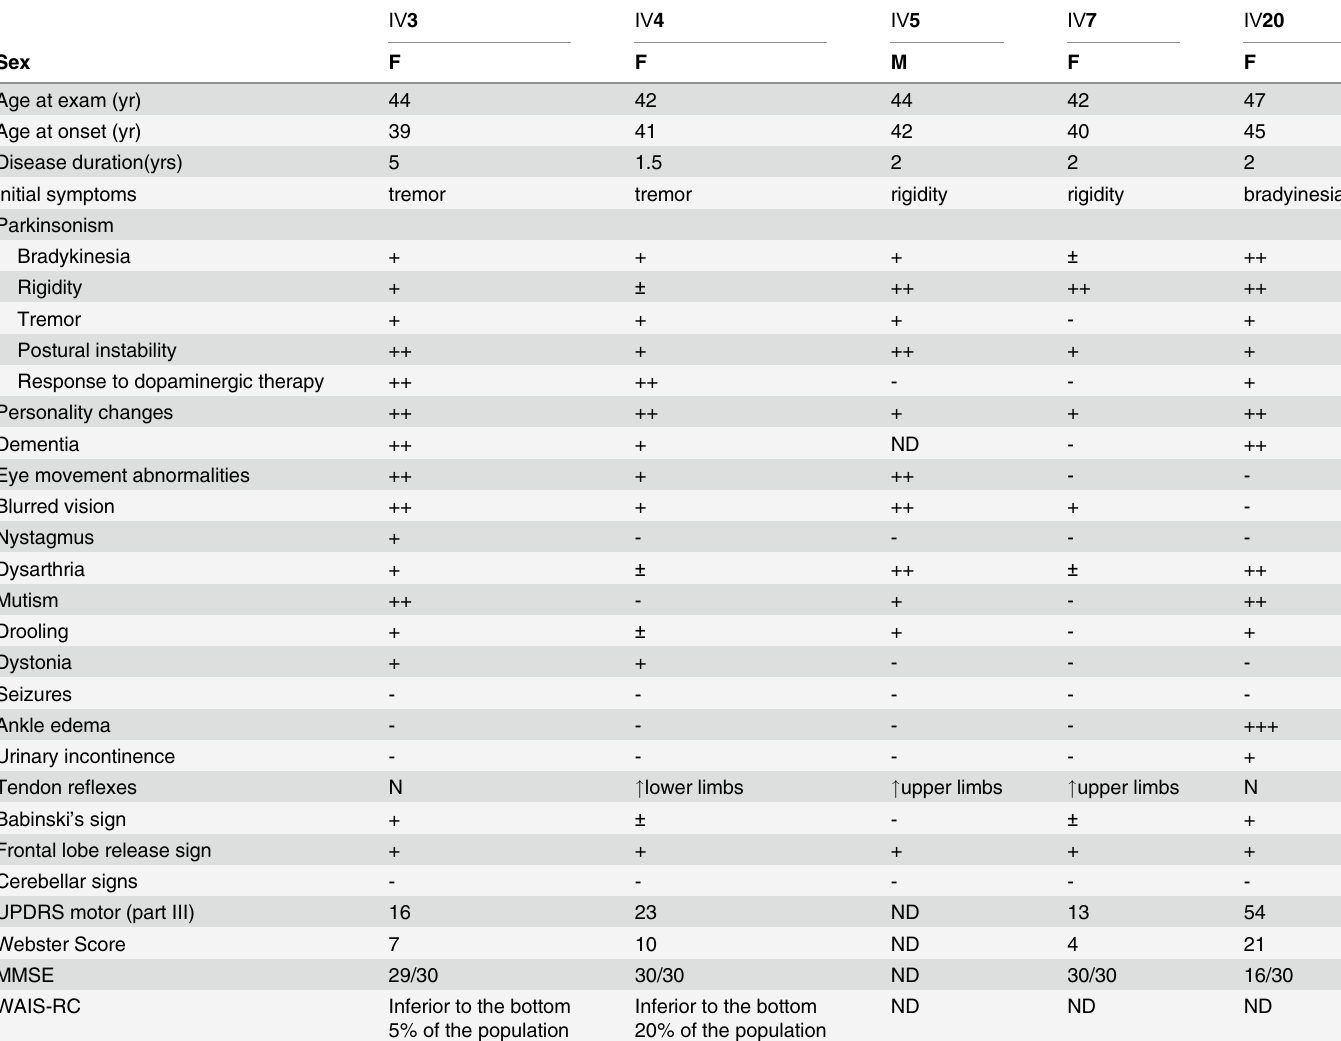
Table 1. Clinical features in five affected members of the